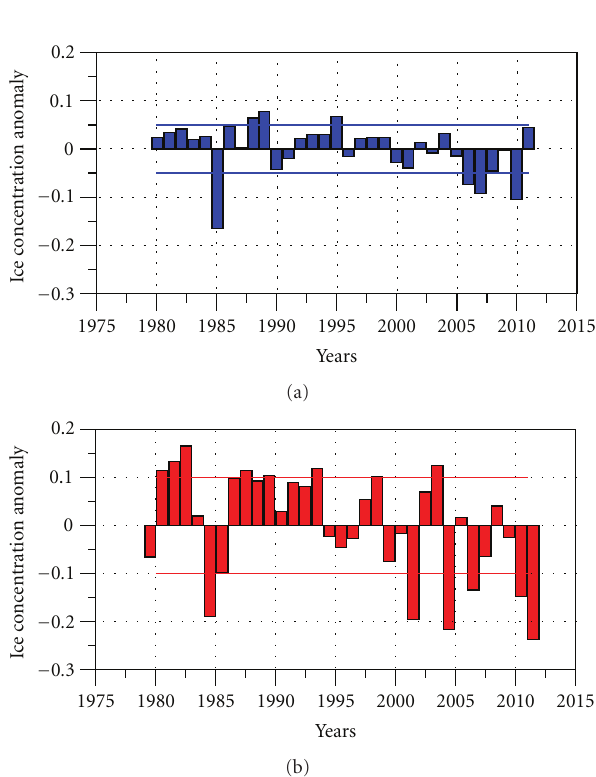
Figure 4: Time series of ice concentration (in parts of the unit) in the WNB (winter: blue; summer: